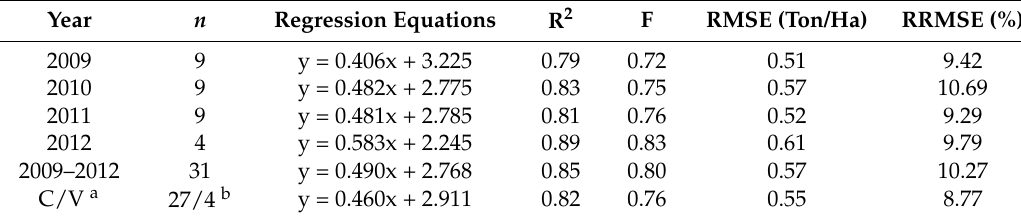
Table 7. Regression equations between data assimilation yield (YIELDs) and field measurement yield (YIELDm) values of winter wheat across the four experiments.